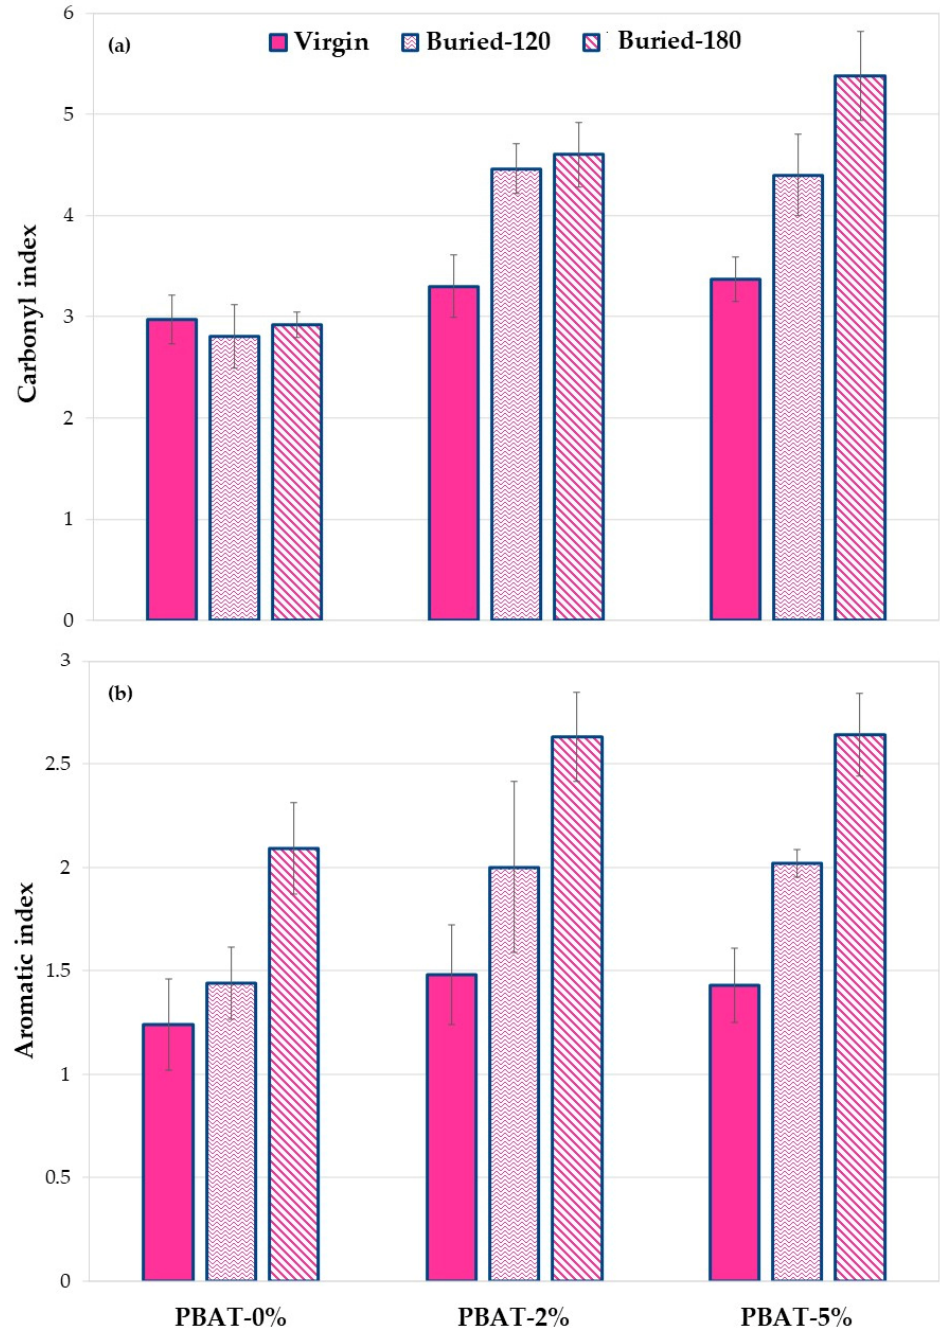
Figure 8. ( a ) Carbonyl and ( b ) aromatic index values for PBAT and nanocomposites film samples, before and after soil burial degradation (120 and 180